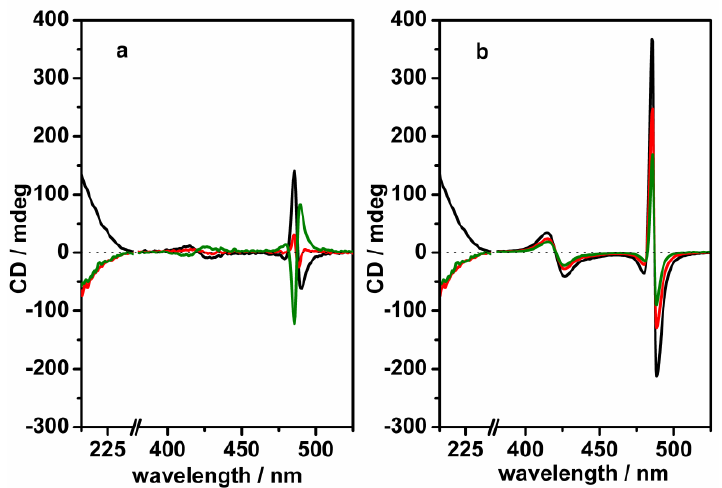
Figure 7. ( a ) CD spectra of the solution of the J-aggregate template on L-Lys 5 mM using the “acid first” procedure before (represented by the black curve), after 24 h (represented by the red curve), and 1 week (represented by the green curve) from the addition of D-Lys 7.5 mM. ( b ) CD spectra of the solution of the J-aggregate template on L-Lys 5 mM using the “acid last” procedure (represented by the black curve), after 24 h in the presence of D-Lys 7.5 mM (represented by the red curve), and after 1 week (represented by the green curve).